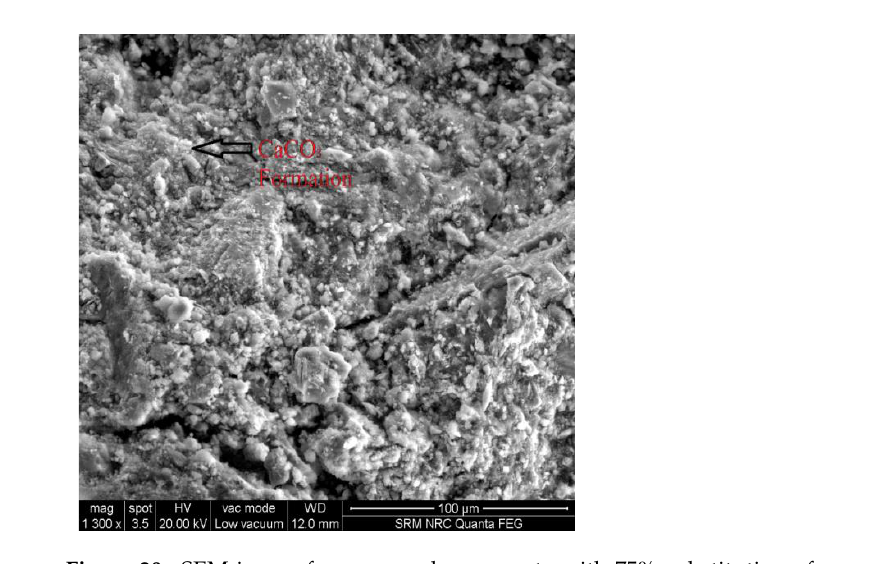
Figure 20. SEM image for copper slag concrete with 75% substitution of copper slag for coarse aggregate and 2% Bacillus subtilis.